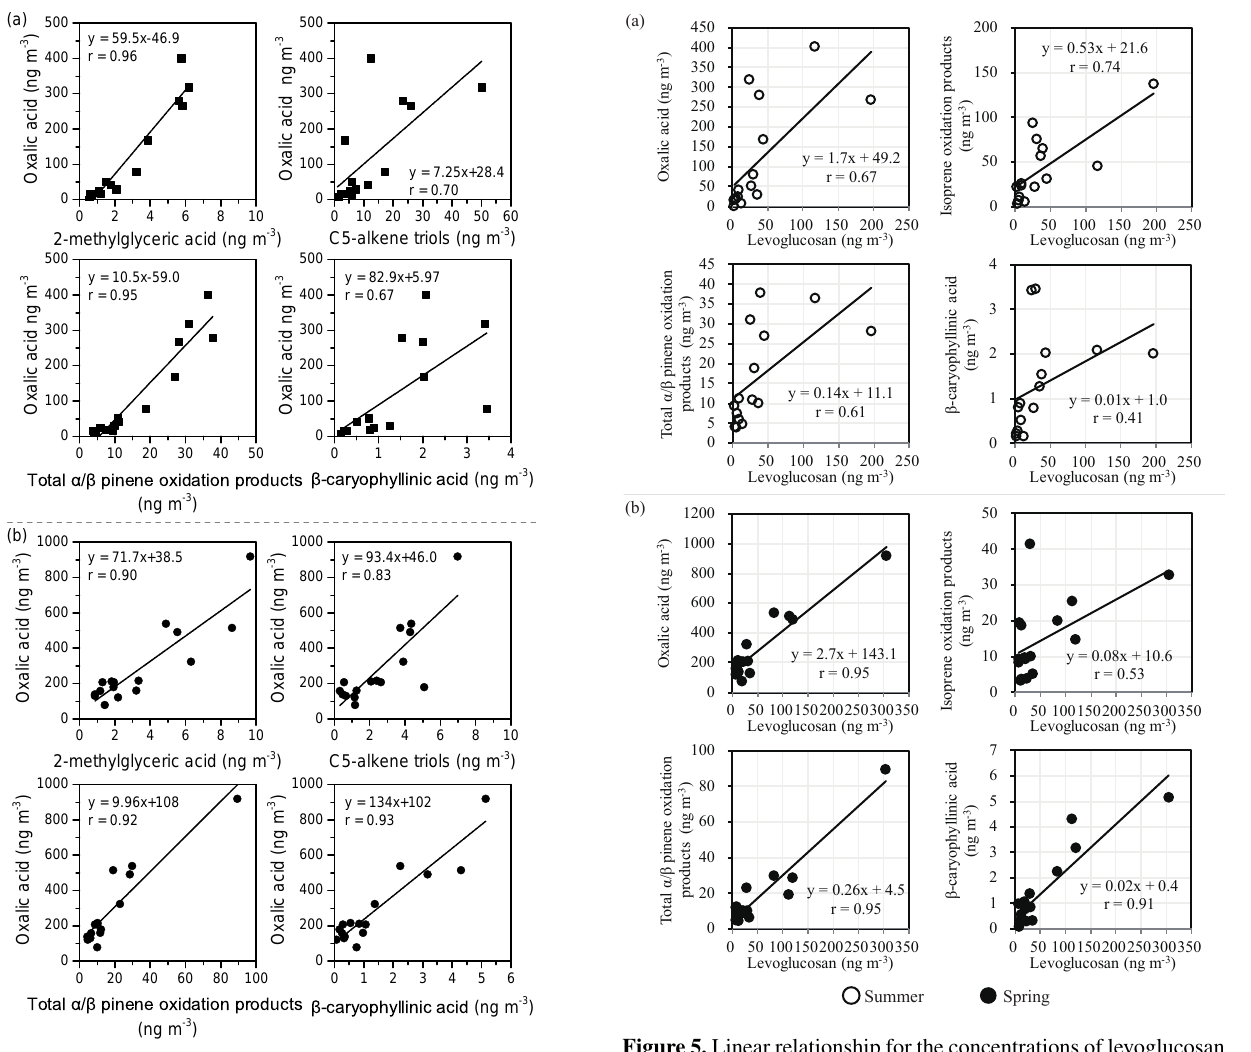
Figure 5. Linear relationship for the concentrations of levoglucosan with oxalic acid, isoprene SOA tracers, α/β -pinene SOA tracers and β -caryophyllene SOA tracer from the aircraft measurements over China during (a) summer and (b)